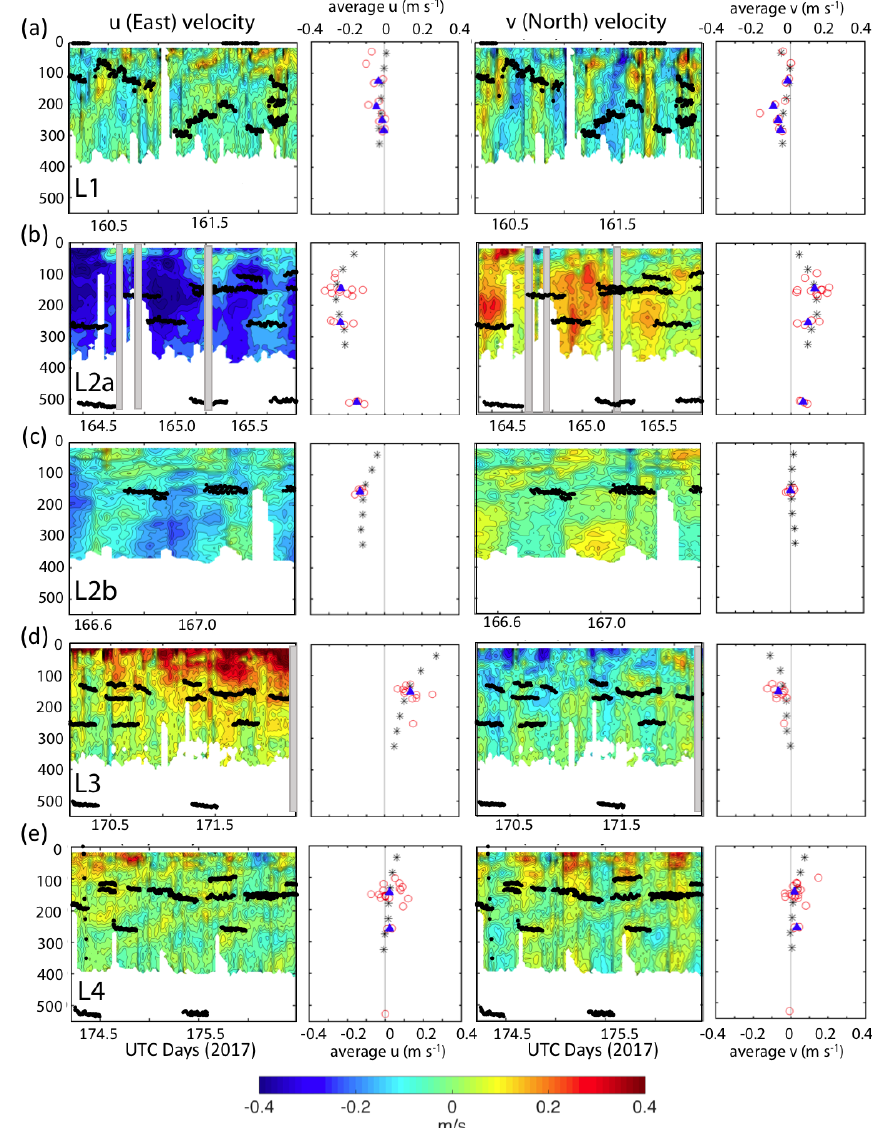
Figure 9. The 30s averaged current velocities in u (east positive) and v (north positive) directions from 150kHz narrow band ADCP data. CFE depths during flux measurements are shown. Profiles denoted by black asterisks to right of each contour plot are averaged ADCP velocities for the entire time span. Red points represent average CFE velocities over the course of each dive. Shaded boxes denote missing data. Filled blue triangles are the averaged CFE velocities for all dives at a given depth. Panels (a) , (b) , (c) , (d) , and (e) Locations 1, 2a, 2b, 3 and 4